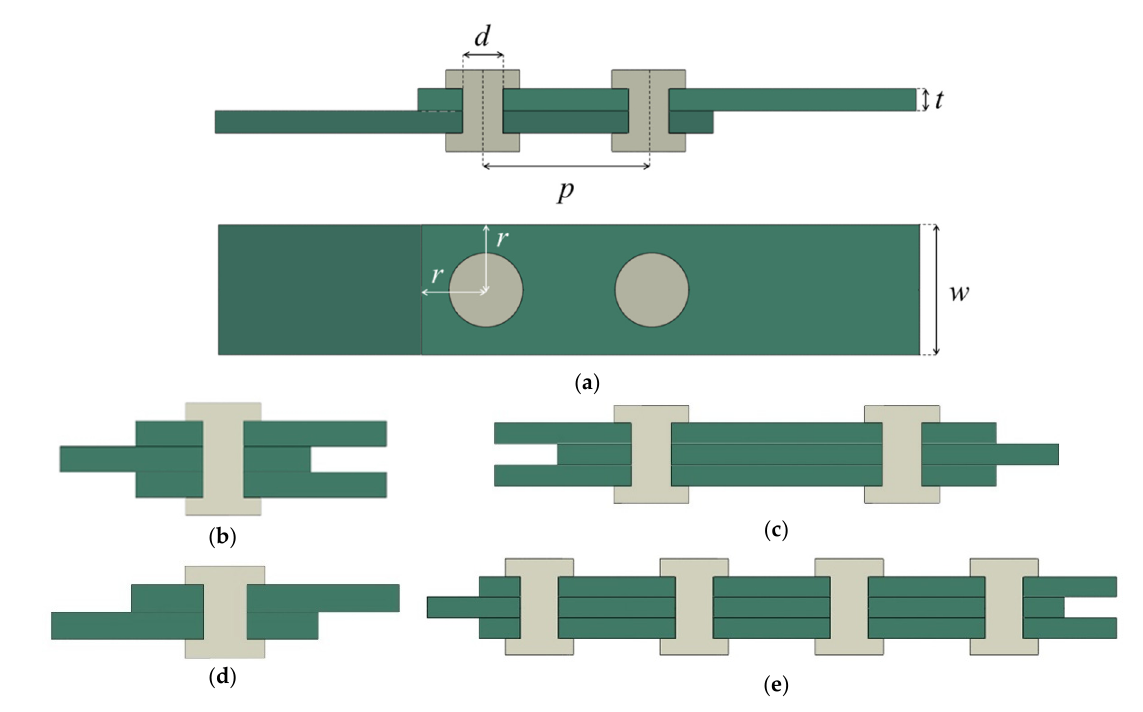
Figure 1. Specimen ( a ) SN-8, ( b ) SN-1, ( c ) SN-7, ( d ) SN-2, ( e ) SN-9, as per Table 1. Table 1. Configurations for riveted specimens adapted from [27].